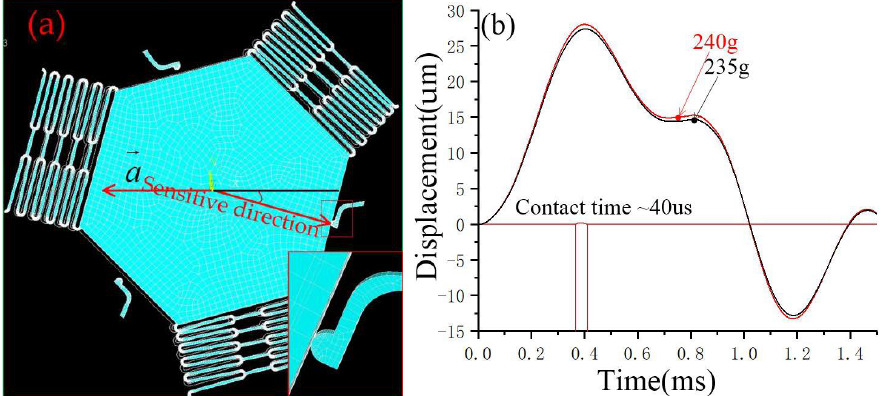
Figure 6. ( a ) Schematic diagram of a movable electrode in contact with a fixed electrode in the directions away from the sensitive direction of 15°; ( b ) the dynamic contact process curves of movable and fixed electrodes in the directions away from the sensitive direction of 15°.